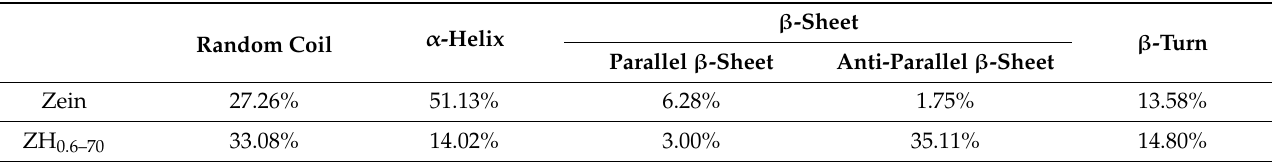
Table 2. Secondary structure of four kinds of zein and ZH 0.6–70